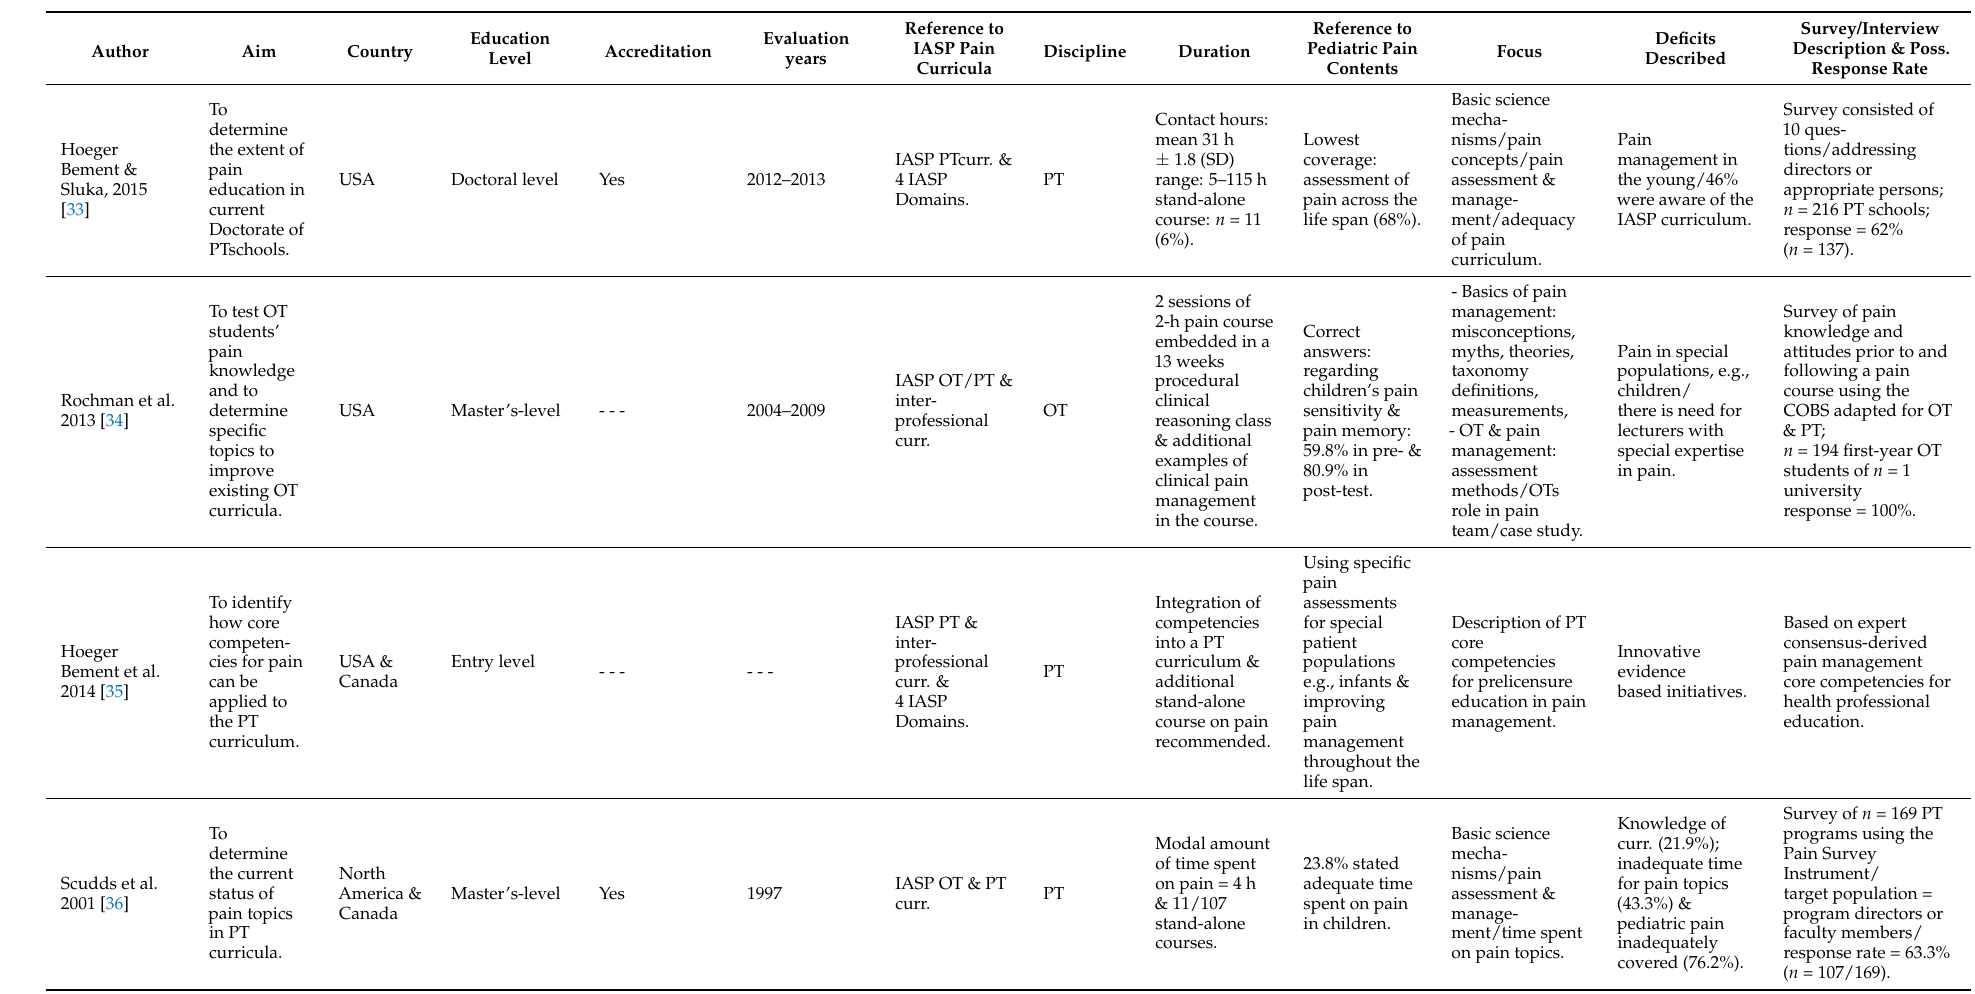
Table 1. Characteristics and main findings of included